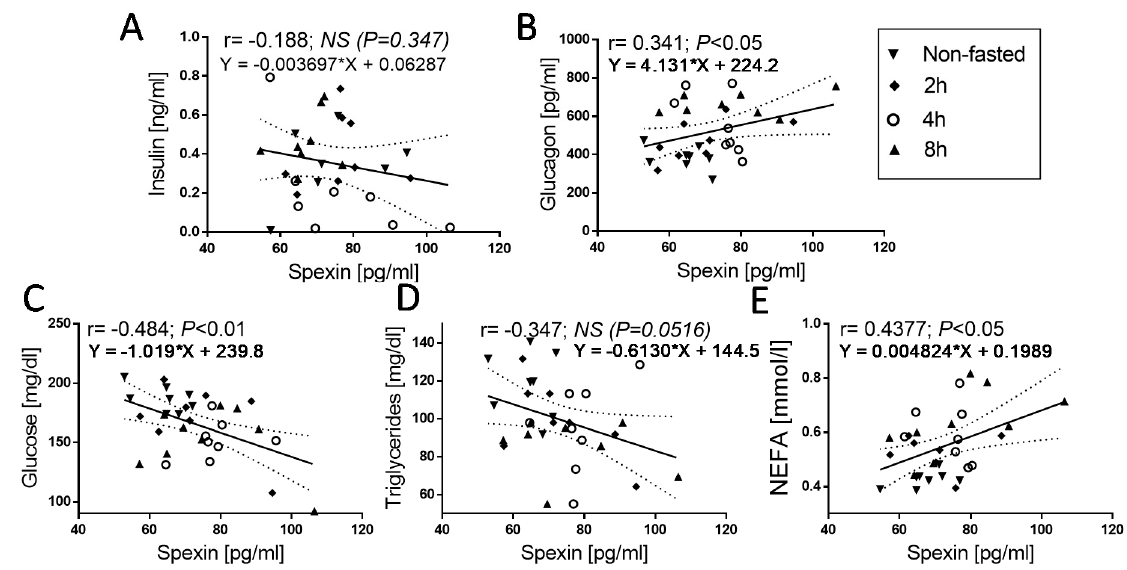
Figure 3. Correlations between circulating SPX concentration and insulin ( A ), glucagon ( B ), glucose ( C ), triglycerides ( D ), and NEFA ( E ) in nonfasted and 2, 4, and 8 h fasted chickens. The values for r and p are indicated in each graph. Solid and dashed lines show the mean and 95% confidence intervals, respectively, following linear-regression analysis; the symbols show the r-Pearson, p -values, and regression formulas. The r-Pearson reflects the correlation, and the p -value indicates the significance of the correlation .